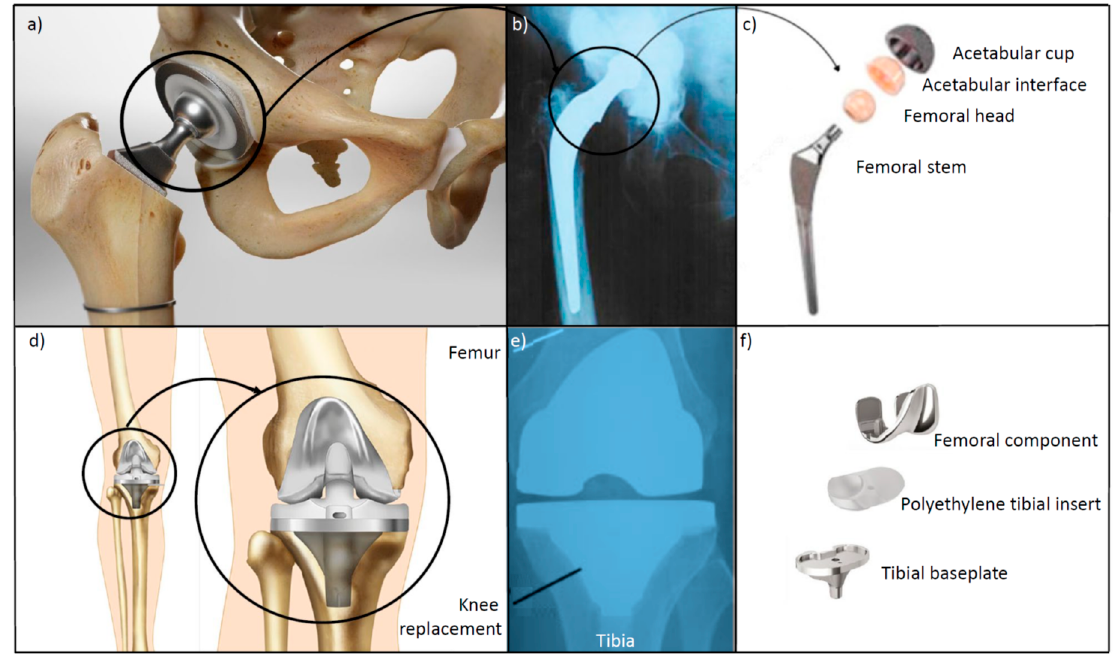
Figure 38. Scheme of application of orthopedic implants ( a – c ) of the hip joint; ( d – f ) knee joint; ( a , d ) general view of the application method; ( b , e ) X-ray pictures after installing the implant in the human body; ( c , f ) assembly diagram for implants’ construction.